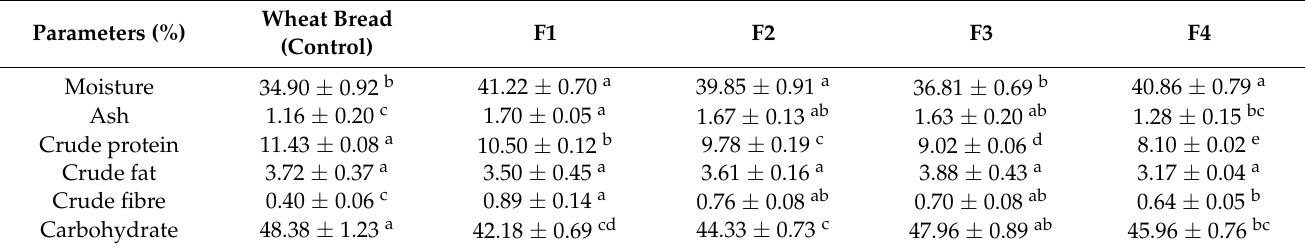
Table 3. Proximate value of wheat bread and gluten-free rice